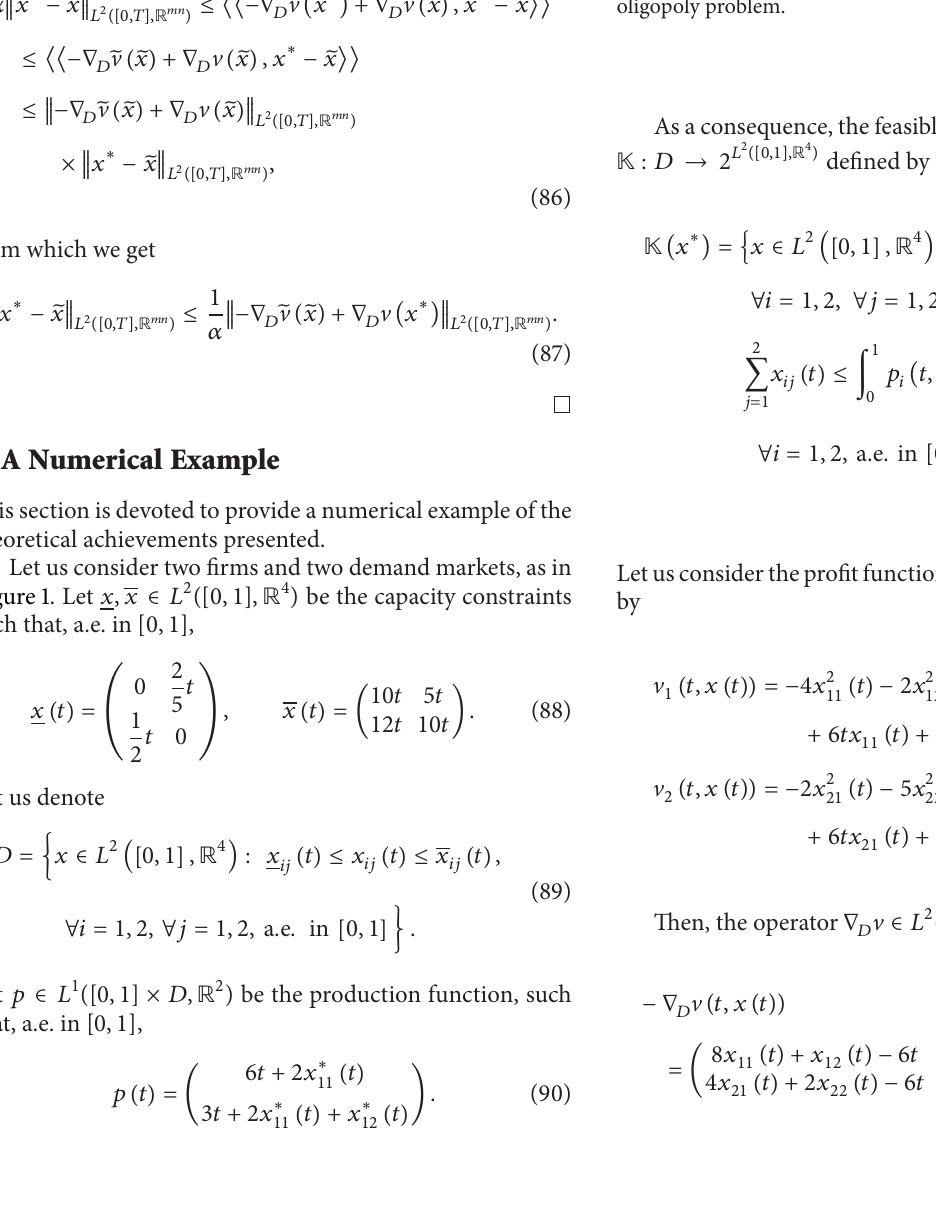
Figure 1: Network structure of the numerical dynamic spatial oligopoly